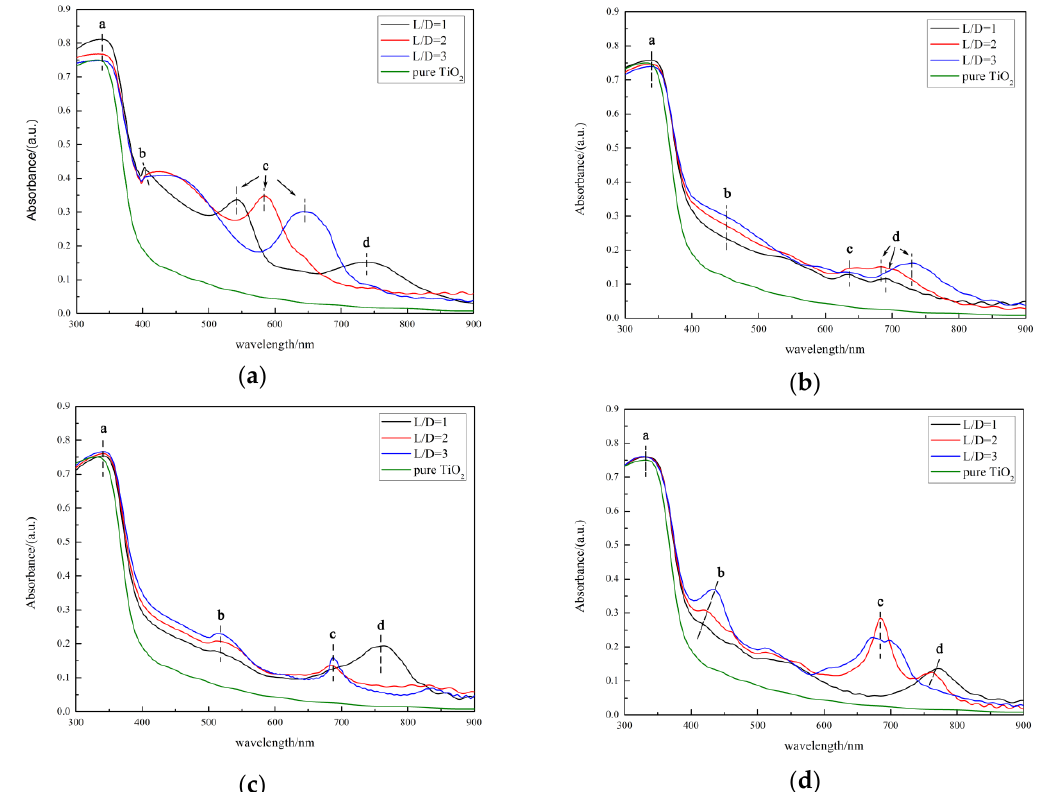
Figure 8. The absorption spectra of Au nanorods loaded on the TiO 2 substrate with different radii and location: ( a ) Model A, ( b ) Model B, ( c ) Model C, and ( d ) Model D as labeled in Figure 1.